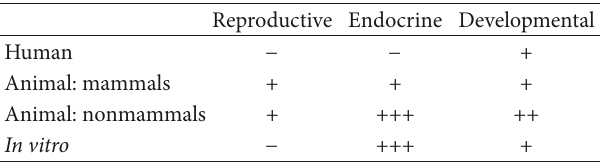
Table 7: Research gaps of the effects of TCC on reproductive, endocrine, and developmental